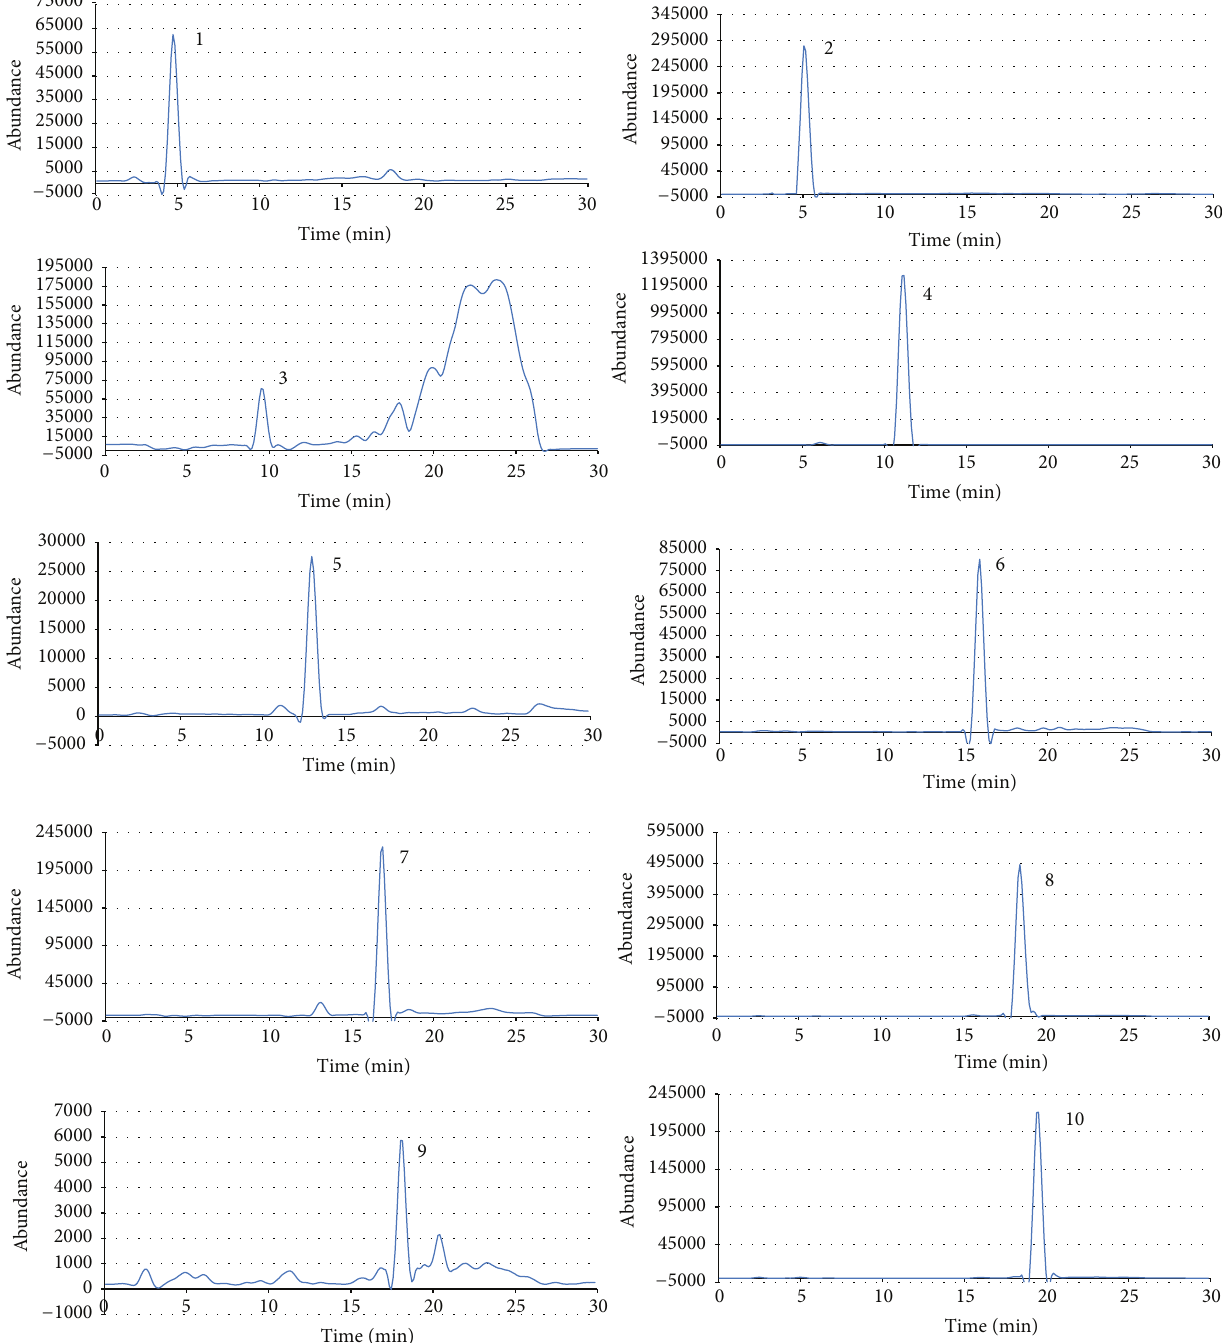
Figure 1: LC-MS chromatogram of a cabbage sample stored for 12 h at 8 ∘ C. Peak 1, progoitrin, 𝑚/𝑧 388.10; peak 2, sinigrin, 𝑚/𝑧 358.20; peak 3, gluconapoleiferin, 𝑚/𝑧 402.41; peak 4, gluconapin, 𝑚/𝑧 372.09; peak 5, glucoalyssin, 𝑚/𝑧 450.19; peak 6, 4-hydroxy-glucobrassicin, 𝑚/𝑧 463.19; peak 7, glucobrassicanapin, 𝑚/𝑧 386.41; peak 8, gluconasturtiin, 𝑚/𝑧 422.19; peak 9, glucobrassicin, 𝑚/𝑧 447.13; and peak 10, neoglucobrassicin, 𝑚/𝑧